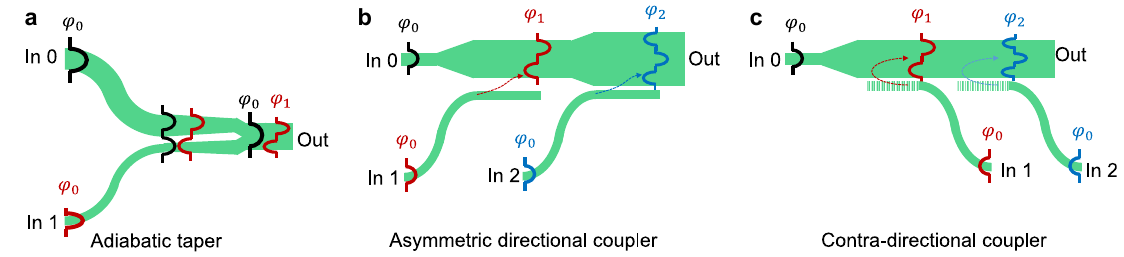
Figure 17: Schematics of typical mode multiplexing architectures that have benefited from SWG engineering: (a) Adiabatic taper, (b) asymmetric DC, and (c) contra DC. The input ports (In 0, 1, 2) support the fundamental mode ( φ 0 ) that the demultiplexer converts to one of the high-order modes ( φ 1,2